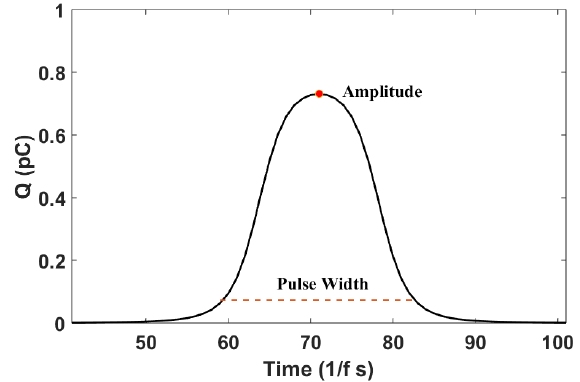
Figure 3. The simulated waveform.